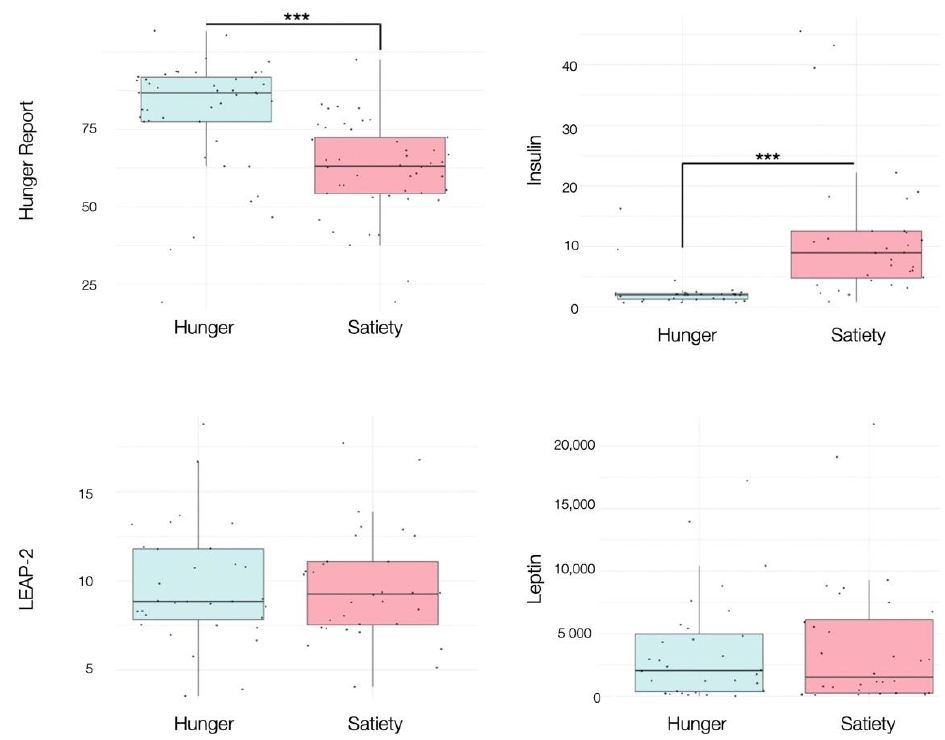
Figure 3. Boxplots showing the effects of hunger and satiety on subjective hunger reports, insulin (mU/L), LEAP-2 (ng/mL), leptin (pg/mL). See main text and Table S2 for statistics. *** p < 0.001.